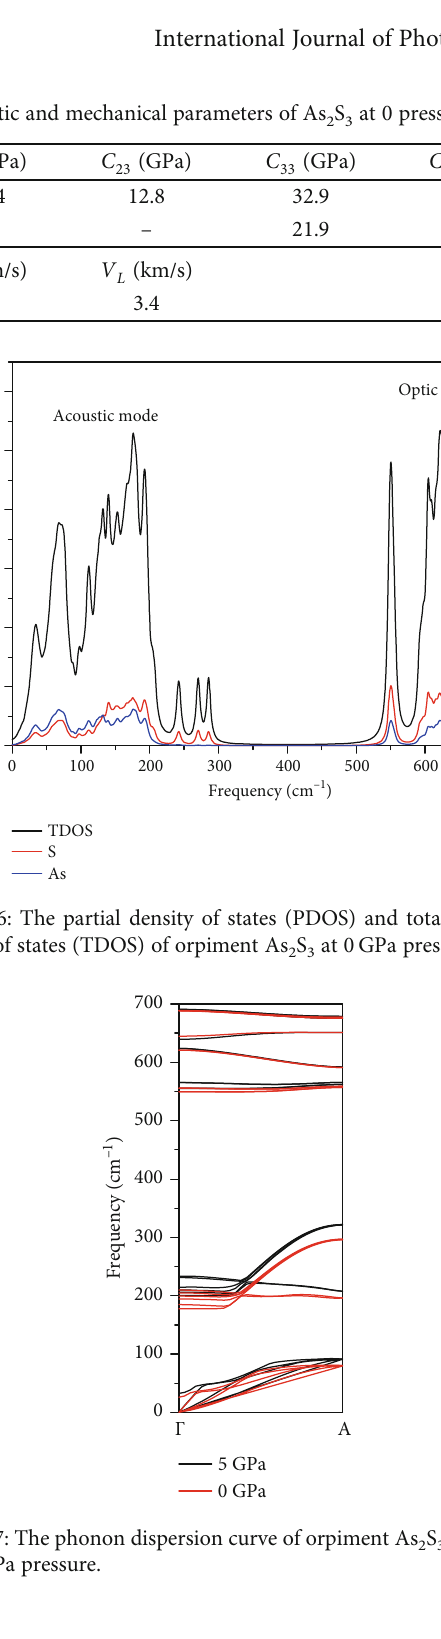
S under pressure. 2 3